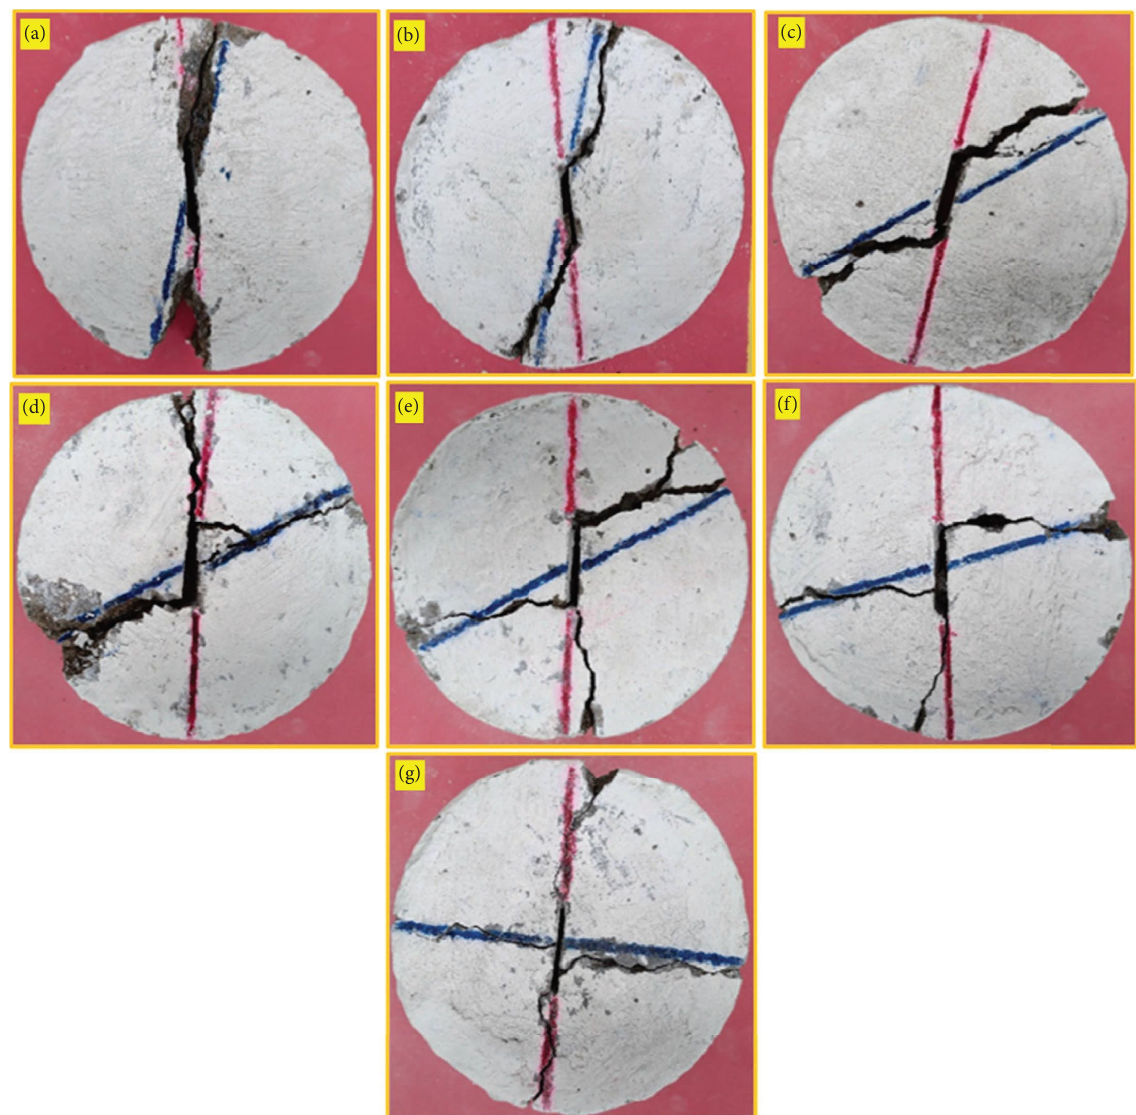
Figure 16: Fracture of nonfbrous specimens at diferent loading angles: (a) 0 ° , (b) 15 ° , (c) 28.83 ° , (d) 45 ° , (e) 60 ° , (f) 75 ° , and (g) 90 °